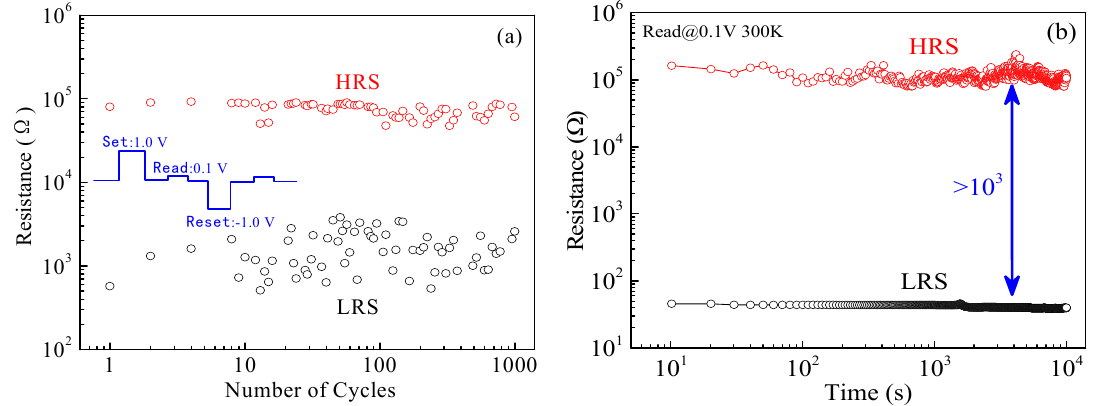
Figure 9. The resistive switching characteristics of the LZO-5 device: ( a ) endurance; ( b ) retention.